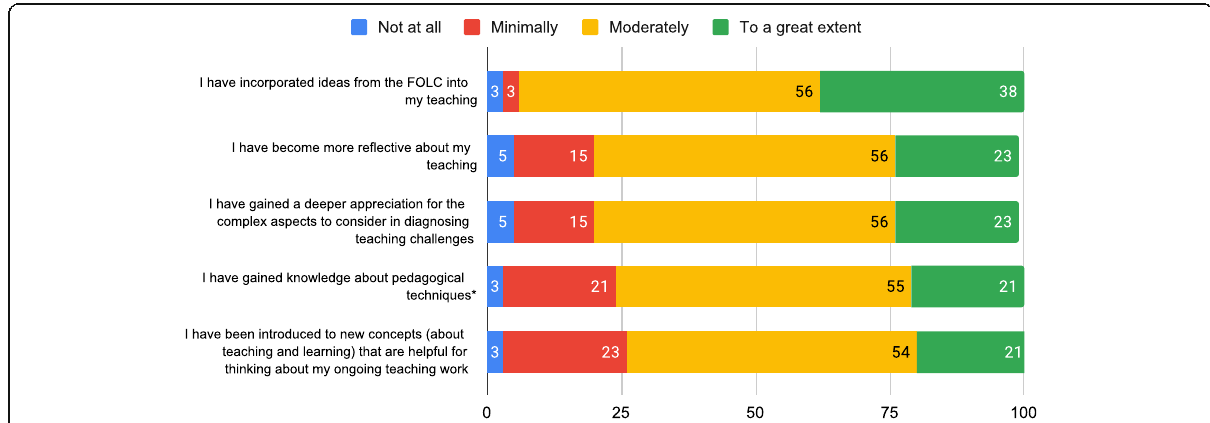
Fig. 5 Teaching practice and pedagogy. Percentage of respondents reporting benefits to participating in the FOLC in spring 2019 (end of year 2 of the FOLC). Participants rated the extent to which each benefit had occurred as a result of their participation in the FOLC. Items were not presented to participants in this order or identified with the category Teaching practice and pedagogy . ( N = 39, except for *. N = 38 for *